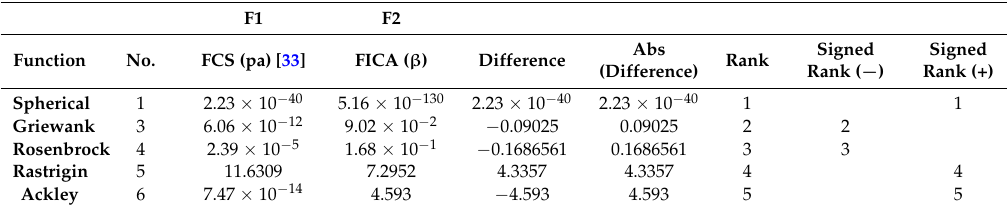
Table 11. Parameters for the statistical test for FICA ( β ) and FCS (pa).